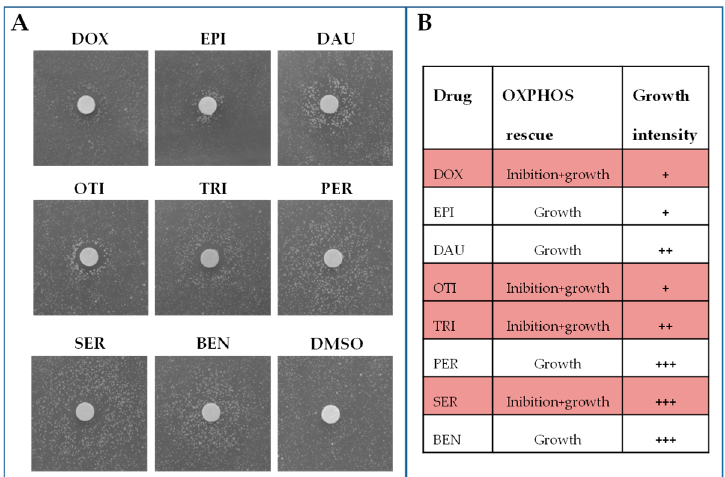
Figure 1. Identification of drugs rescuing the oxidative growth of WB-12/ aac2 M114P mutant. ( A ) 4.5 × 10 5 cells of the WB-12/ aac2 M114P mutant strain were spread on a 120 × 120 mm square plate containing solid YP medium supplemented with lactate 2%. Sterile filters were added on the agar surface, and 2.5 μ L of the different drugs at the concentration of 10 mM were loaded. One filter was loaded with the same amount of DMSO, the solvent in which the molecules were solubilized, as negative control (C-). Positive hits were identified after 72–96 h incubation at 28 °C by the halo of growth around the filters. ( B ) Rescuing effect on the oxidative growth: +++ Strong effect; ++ Medium effect; + Mild effect. DOX = doxorubicin, EPI = epirubicin HCl, DAU = daunorubicin HCl, OTI = otilonium bromide, PER = pergolide mesylate, TRI = trifluoperazine 2HCl, SER = sertraline HCl, BEN = benzydamine HCl.